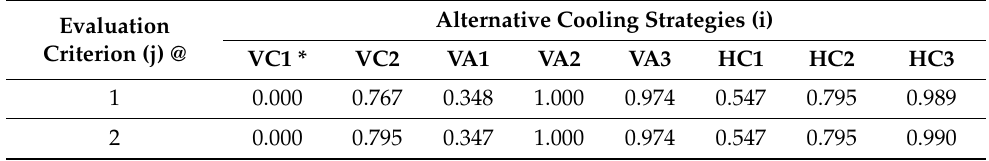
for cooling maritime arid climatic ij